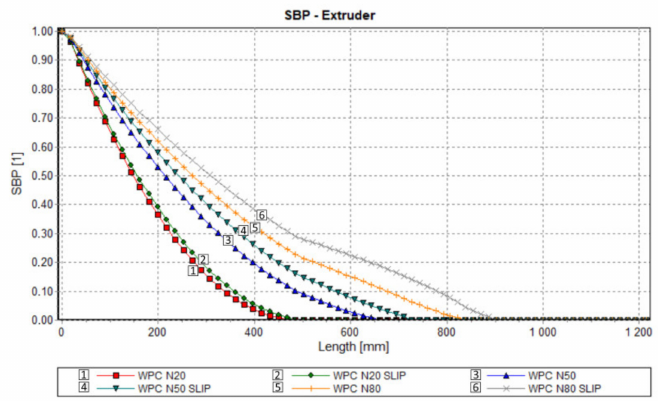
Figure 13. Process simulation: Melting